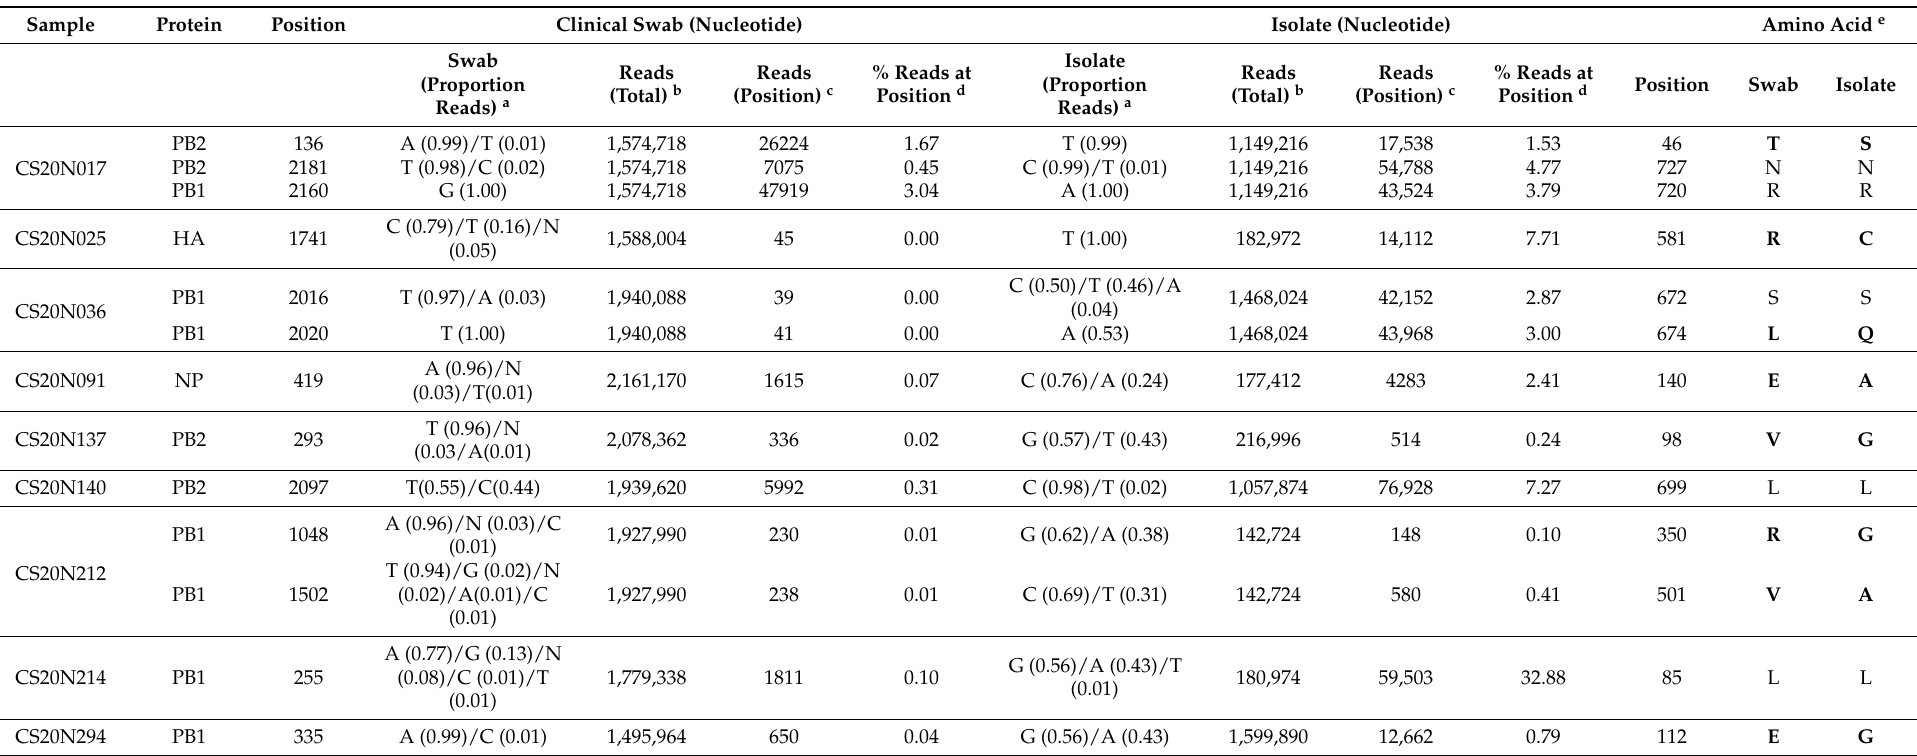
a Swab (Proportion Reads) and Isolate (Proportion Reads) refer to the frequency of each nucleotide (A, T, G, or C) compared with the total number of reads (all A, T, G, and C) generated at a specific genomic position. b Reads (total) refers to the total number of reads generated during whole genome sequencing for each sequence analyzed. c Reads at Position refers to the number of reads generated by whole genome sequencing at each position of the genome. d % Reads at Position was calculated by [Reads at Position/Reads (total) × 100]. e Nonsynonymous mutations are highlighted in bold in the amino acid